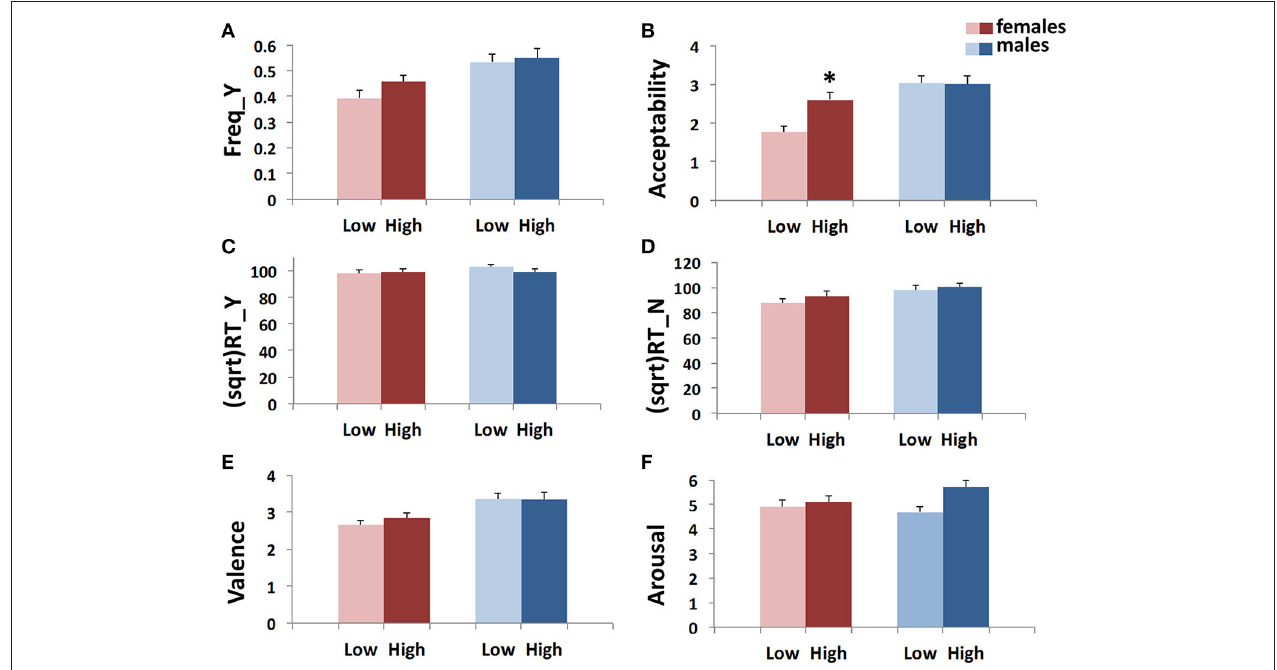
FIGURE 2 | Association results between the dopaminergic dichotomic Multilocus variable and Freq_Y (A) , Acceptability (B) , (sqrt)RT_Y (C) , (sqrt)RT_N (D) , Valence (E) , and Arousal (F) in the two genders. Bars represent mean ± SEM. 0.01 < * p -value ≤